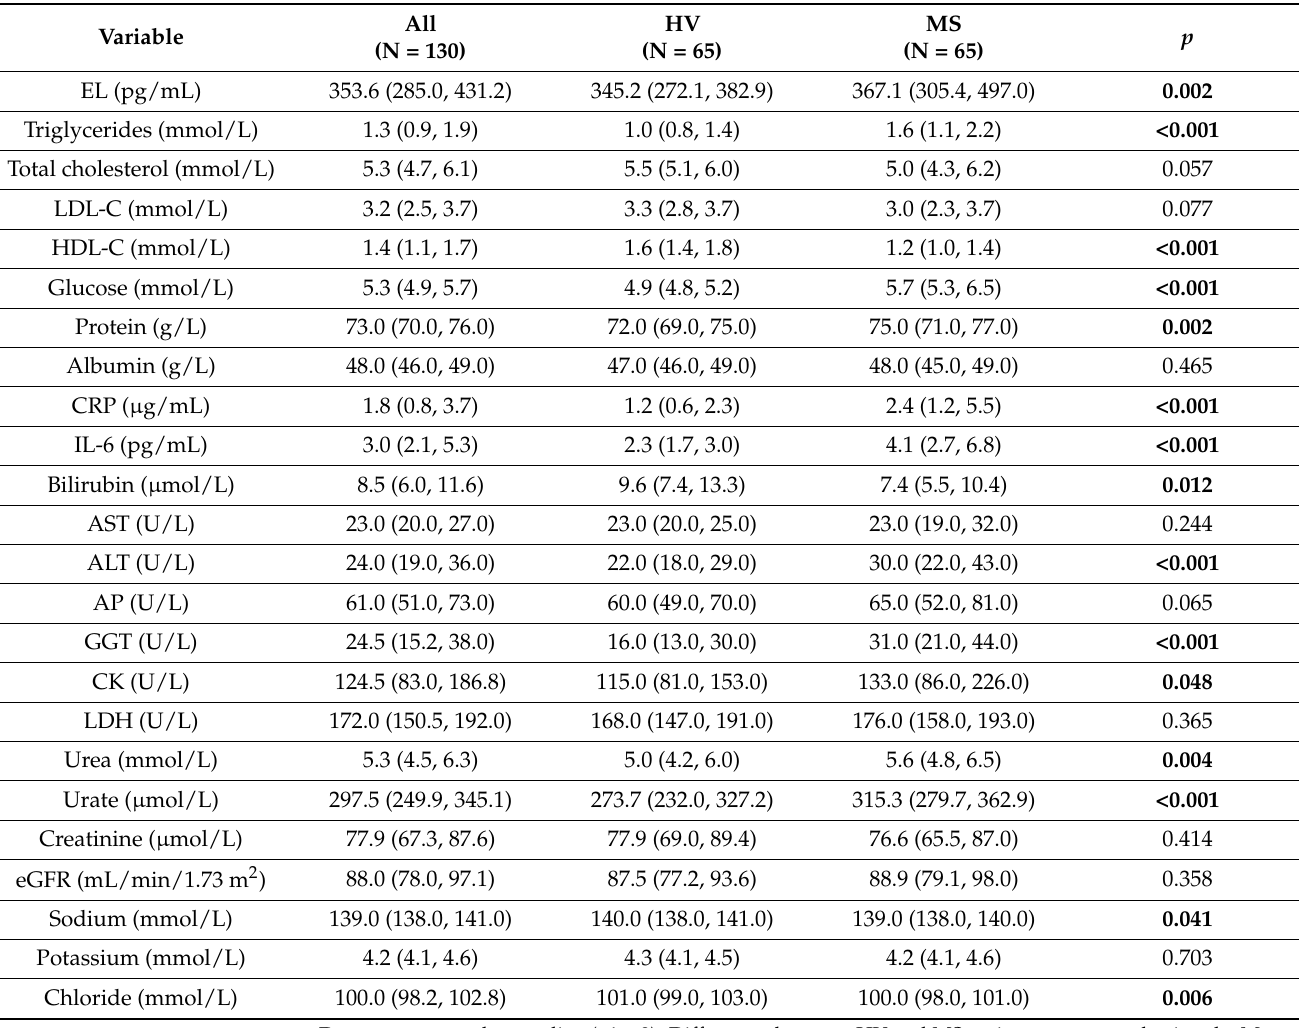
Table 2. Differences in laboratory data between HV and MS